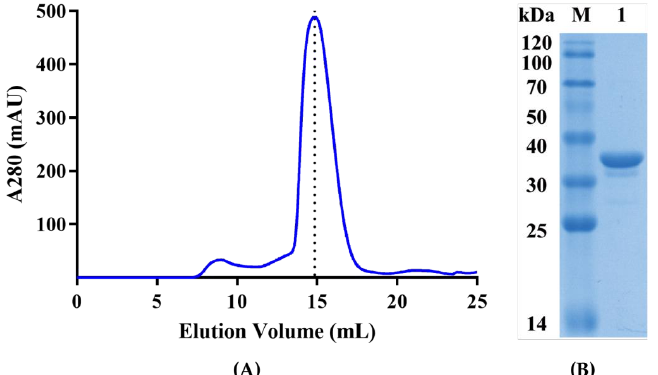
Figure 2. Purification of PaAst. ( A ) Size-exclusion chromatography of recombinant PaAst. The elution volume was 14.85 mL, between standard samples ovalbumin (44 KD) and conalbumin (75 KD), and closer to conalbumin. ( B ) SDS-PAGE analysis of the purified recombinant PaAst. Lane M, protein marker; Lane 1, purified recombinant PaAst. Recombinant PaAst was enzymatically active towards p NPS, a common artificial substrate to evaluate enzymatic activities of the arylsulfatases [12]. The purification yields of PaAst are shown in Table 1 after procedures of crude extraction, Ni 2+ affinity chroma- tography, and size-exclusion chromatography. After the steps of Ni 2+ affinity chromatog- raphy, dialysis, and a secondary Ni 2+ affinity chromatography, the total protein decreased from 220.32 mg to 22.93 mg, but the specific activity increased by three folds. The size- exclusion chromatography had less effect on the activity than the former steps, and the final yield for purification was 14.76%. The final yield and purification factor for PaAst were higher than AtsA heterologous expressed in E. coli performed with the same proce- dures in the same conditions (Table A2). The specific activity of purified PaAst on p NPS was 39.45 U/mg at 50 °C. The kinetic parameters were also obtained at 50 °C by exhibiting a Michaelis – Menten plot with specific activities on different concentrations of p NPS (Fig- ure 3). The purified recombinant PaAst was observed with K m and V max of 1.00 mM and 60.80 U/mg, respectively. The results demonstrated that PaAst could hydrolyze p NPS ef- ficiently, indicating its belonging to the arylsulfatase family.